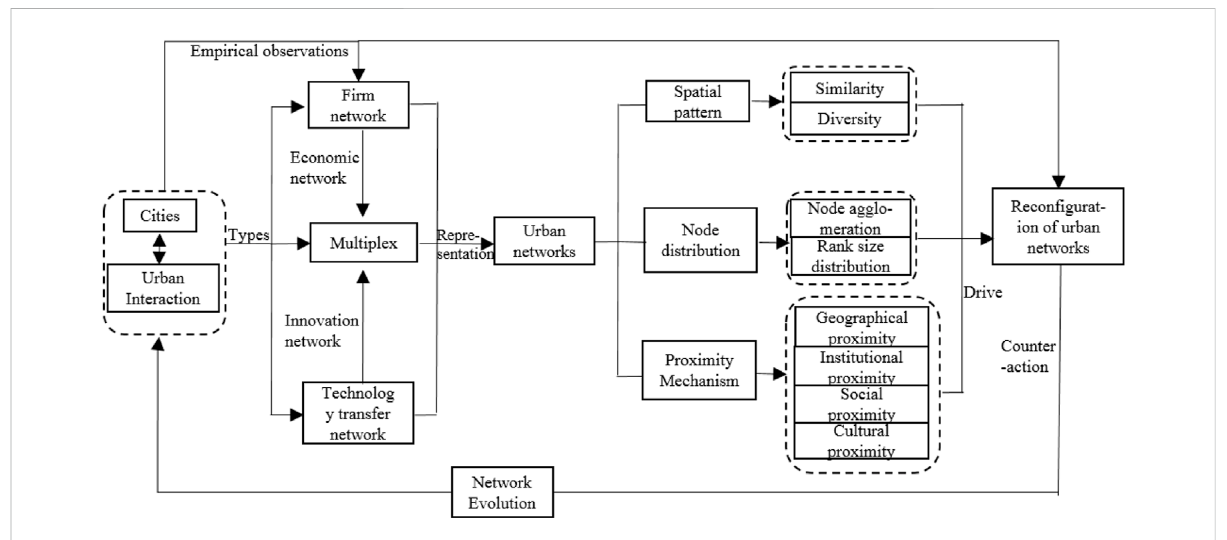
FIGURE 1 Constructive and analytical framework of urban